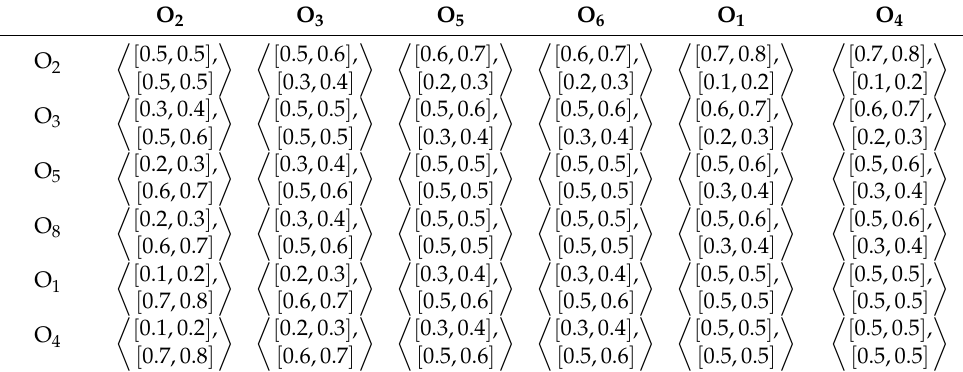
Table 14. Aggregated decision interval matrix in IVPF–AHP for the sub-criteria O (CI =